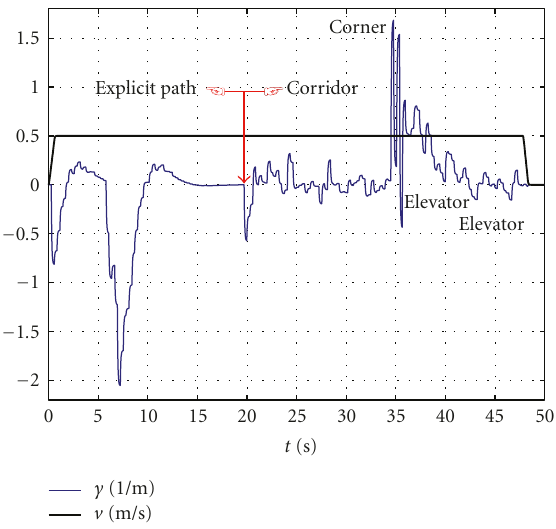
Figure 14: Curvature and speed of Auriga- α when following an explicit path and a